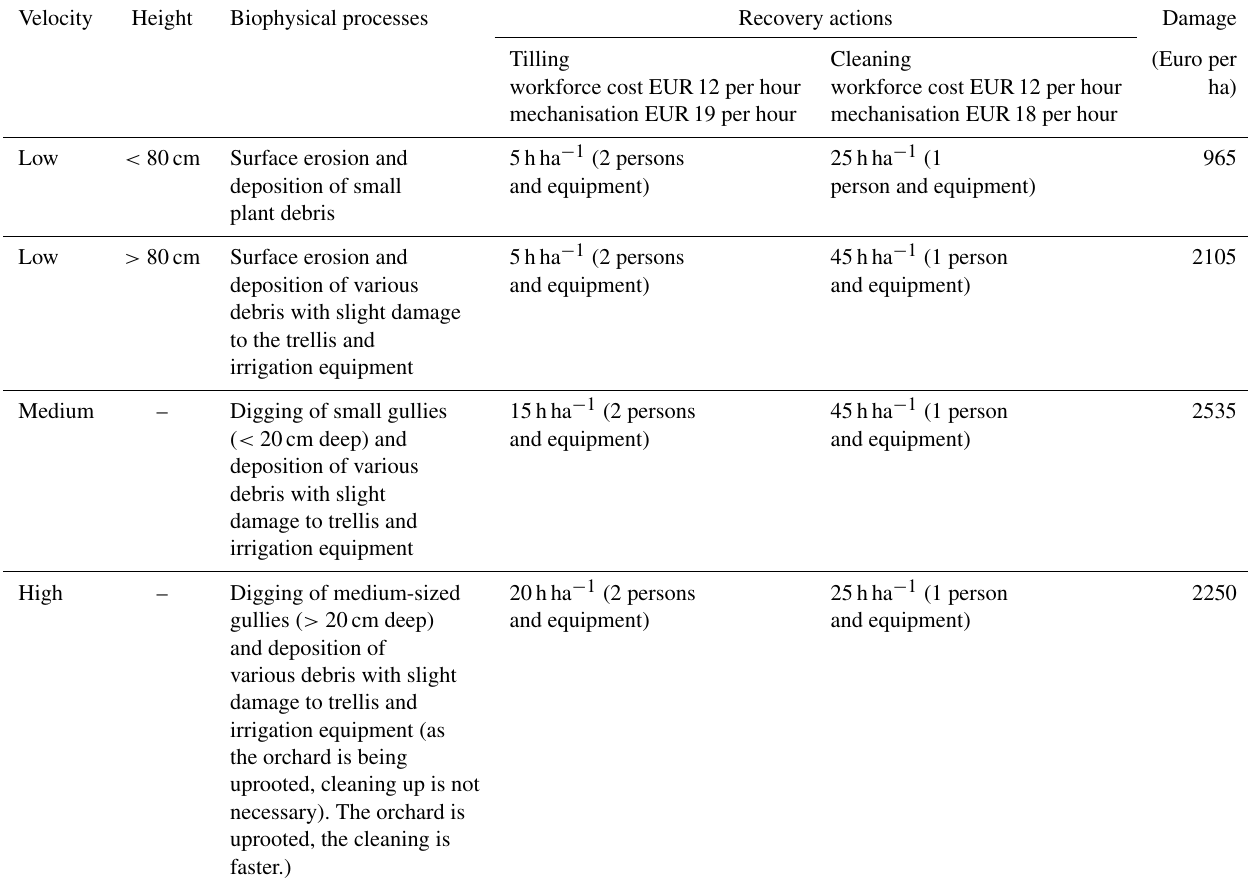
Table 8. Illustration of assumptions elaborated with experts for soil damage in the case of orchards for the national damage functions.